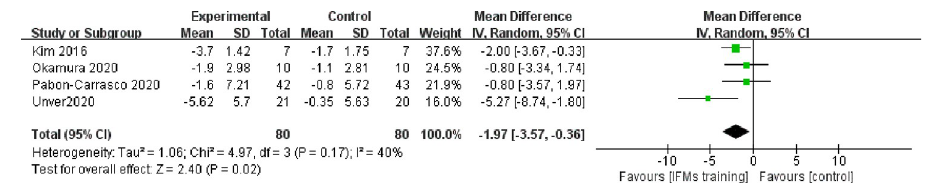
Fig 2. Forest plot illustrating navicular drop of meta-analysis comparing IFMs training with control group.